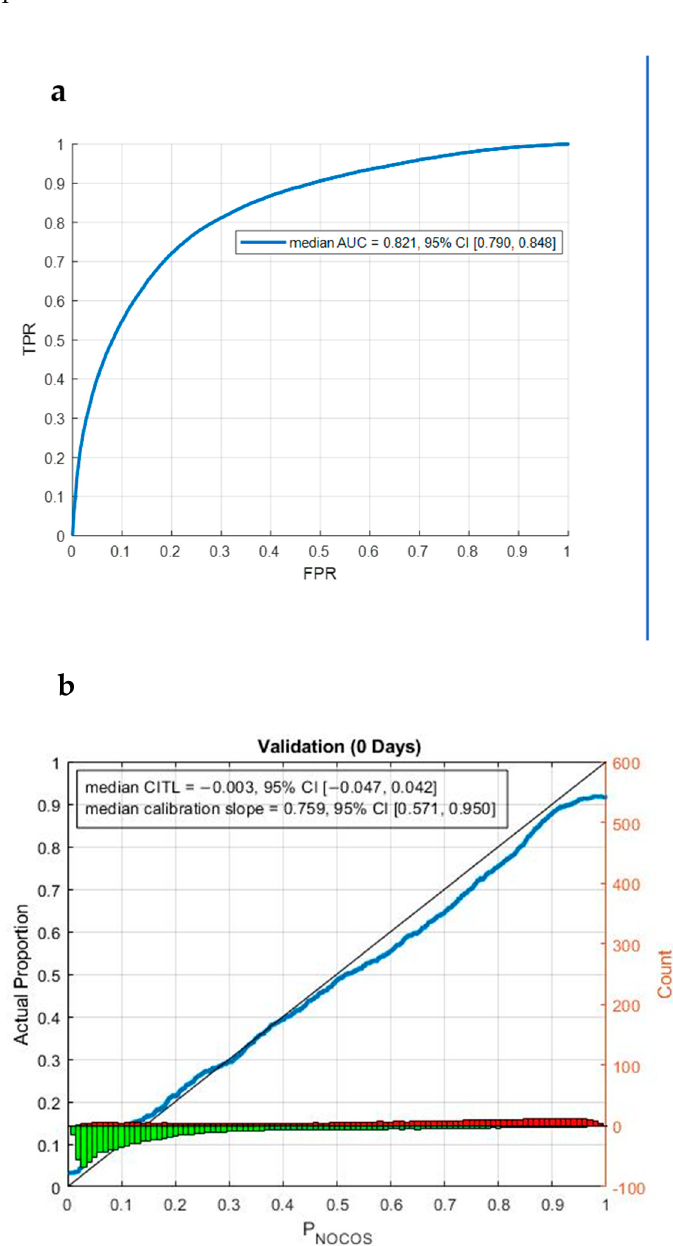
Figure 1. Machine learning model. ( a ) ROC curve discriminative performance of the logistic regres- sion machine learning model comparing no hesitancy with combined mild hesitancy and significant hesitancy. The median AUC and 95% CI are reported; ( b ) calibration performance of the machine learning model. The blue trace is the smoothed probabilities, the black line indicates the ideal cali- bration, the red and green histograms are the counts of the binned probabilities for vaccine hesitant and non-hesitant patients, respectively (TPR = true positive rate, FPR = false positive rate, AUC = area under the receiver operating characteristic curve, CITL = calibration-in-the-large).